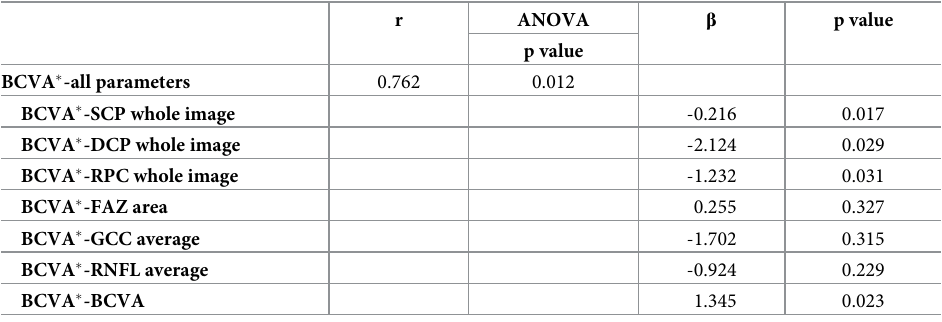
Table 2. Multiple linear regression model between OCTA, SD-OCT and BCVA parameters at baseline and BCVA after surgery via endoscopic endonasal